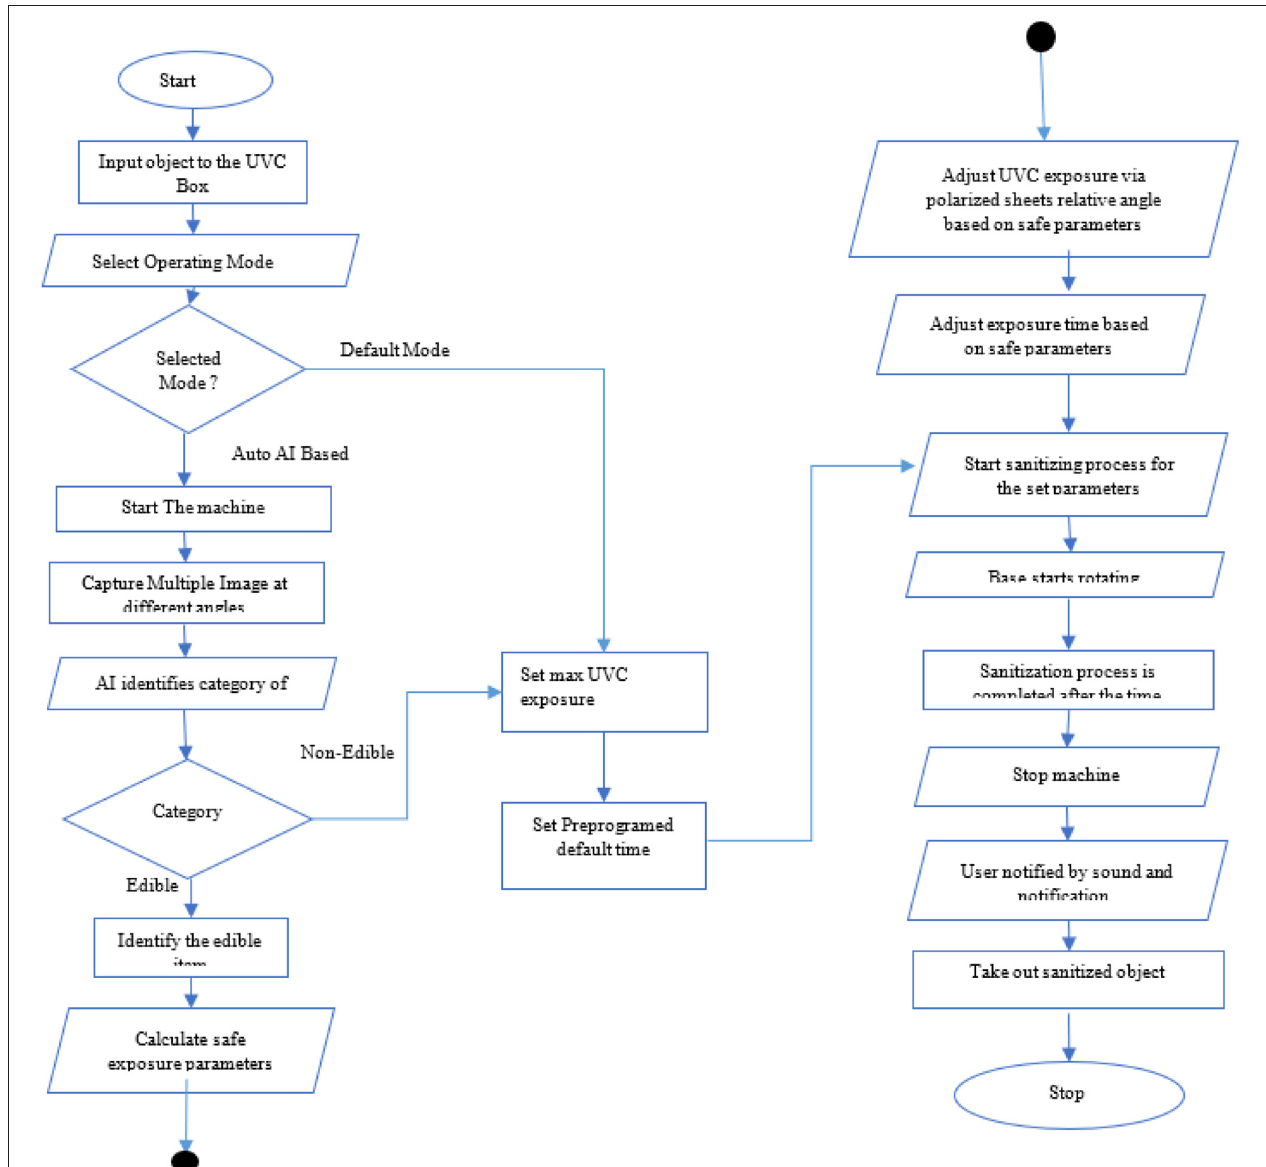
FIGURE 5 | Main process flow